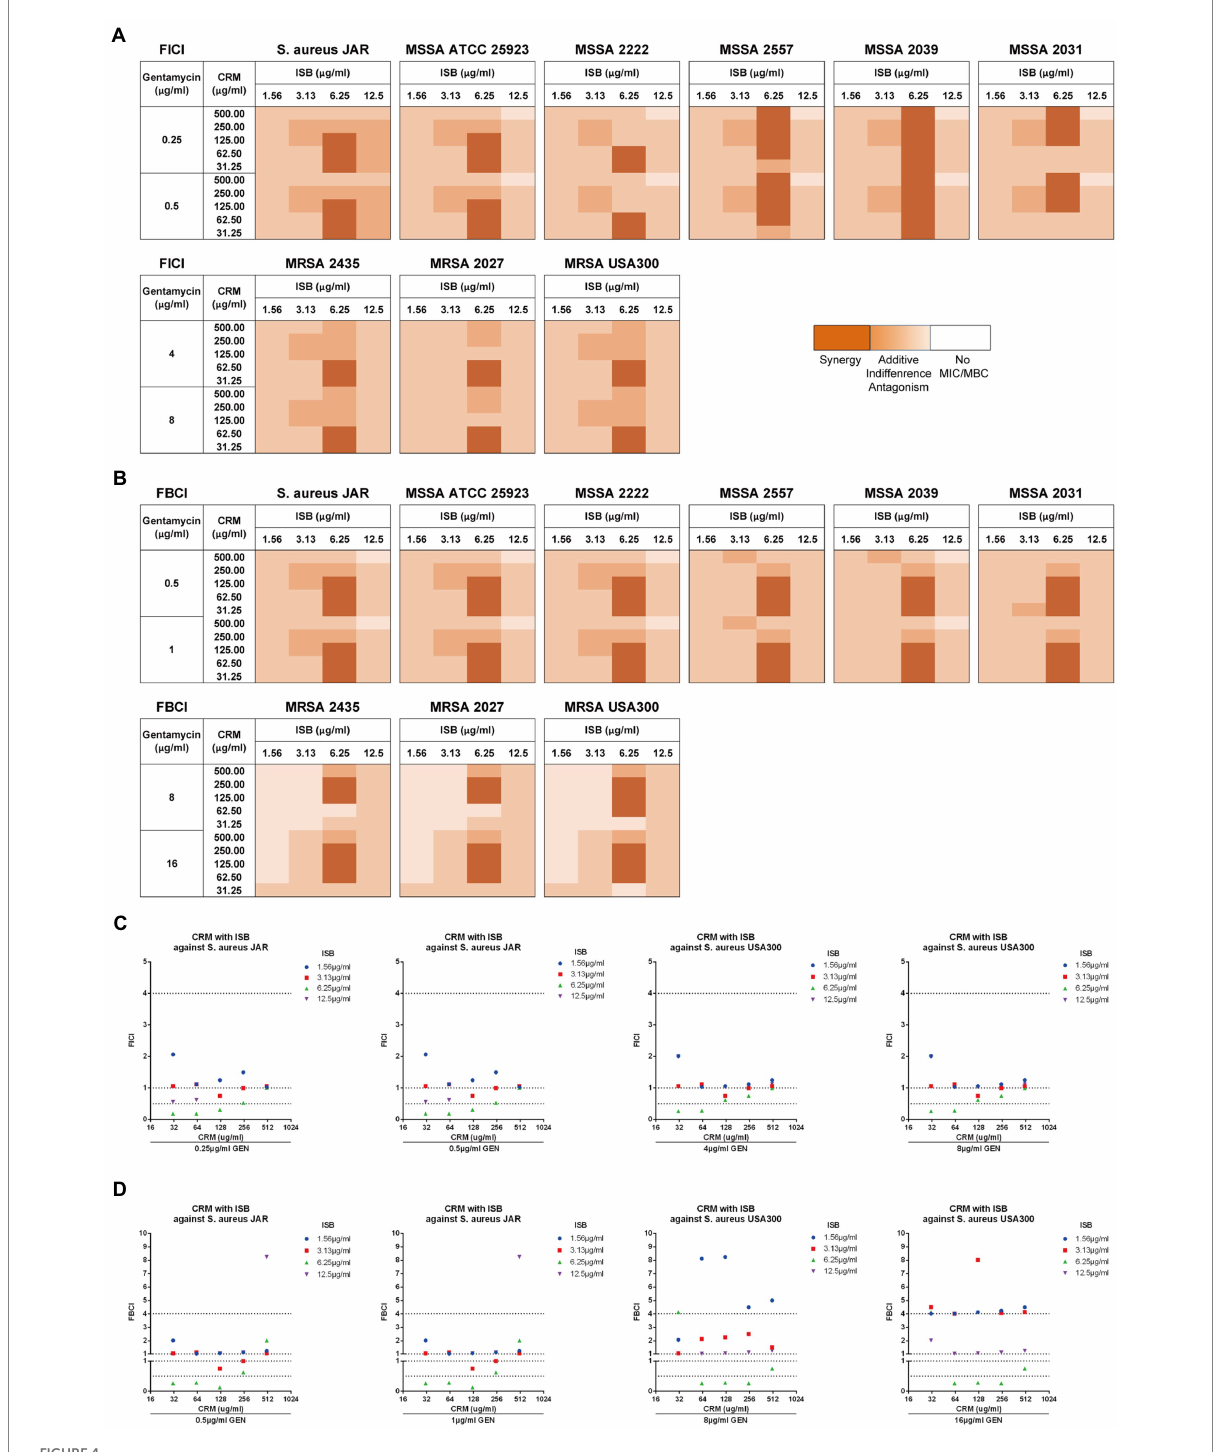
FIGURE 4 EUCAST checkerboard assay showed isobavachalcone and curcumin interact synergistically with presence of gentamycin against planktonic Staphylococcus aureus . (A,B) Heatmaps of fractional inhibitory concentration index (FICI) and fractional bactericidal concentration index (FBCI) of combination of isobavachalcone and curcumin, darker orange color indicates interaction is superimposed or synergistic. (C) FICI of isobavachalcone with curcumin against S. aureus JAR and USA300 strain. (D) FBCI of isobavachalcone with curcumin against S. aureus JAR and USA300 strain. FICI ≤ 0.5 represents synergy, FICI > 0.5–4 represents no synergistic interaction, and FICI > 4.0 represents antagonism. CDI < 1, =1 or >1 indicate synergy, superposition or antagonism, respectively, CDI < 0.7 indicates significant synergism. Data were presented as mean ± SD. FICI, fractional inhibition concentration index; FBCI, fractional bactericidal concentration index; GEN, Gentamycin; ISB, Isobavachalcone; CRM, Curcumin; CDI, Coefficient of Drug Interaction; MSSA, Methicillin-susceptible Staphylococcus aureus ; MRSA, Methicillin-resistant Staphylococcus aureus